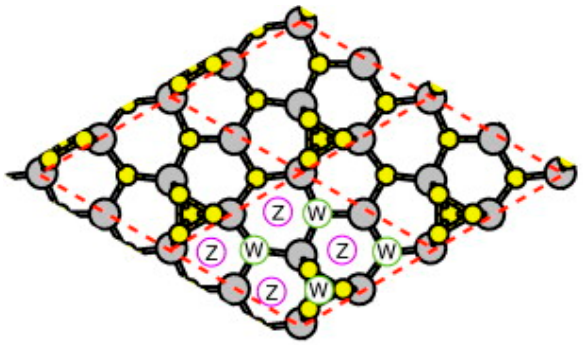
Figure 22. Top view of the ( 2 × 2 ) surface with P trimer surface. Red dashed lines correspond to the (2 × 2) unit cells. Large and small circles represent In and P atoms, respectively. Symbols of W and Z stand for In lattice sites in the WZ and ZB structures, respectively. Reprinted with permission from [97]. Copyright (2013) by Elsevier. Crystals 2017 , 7 , 46